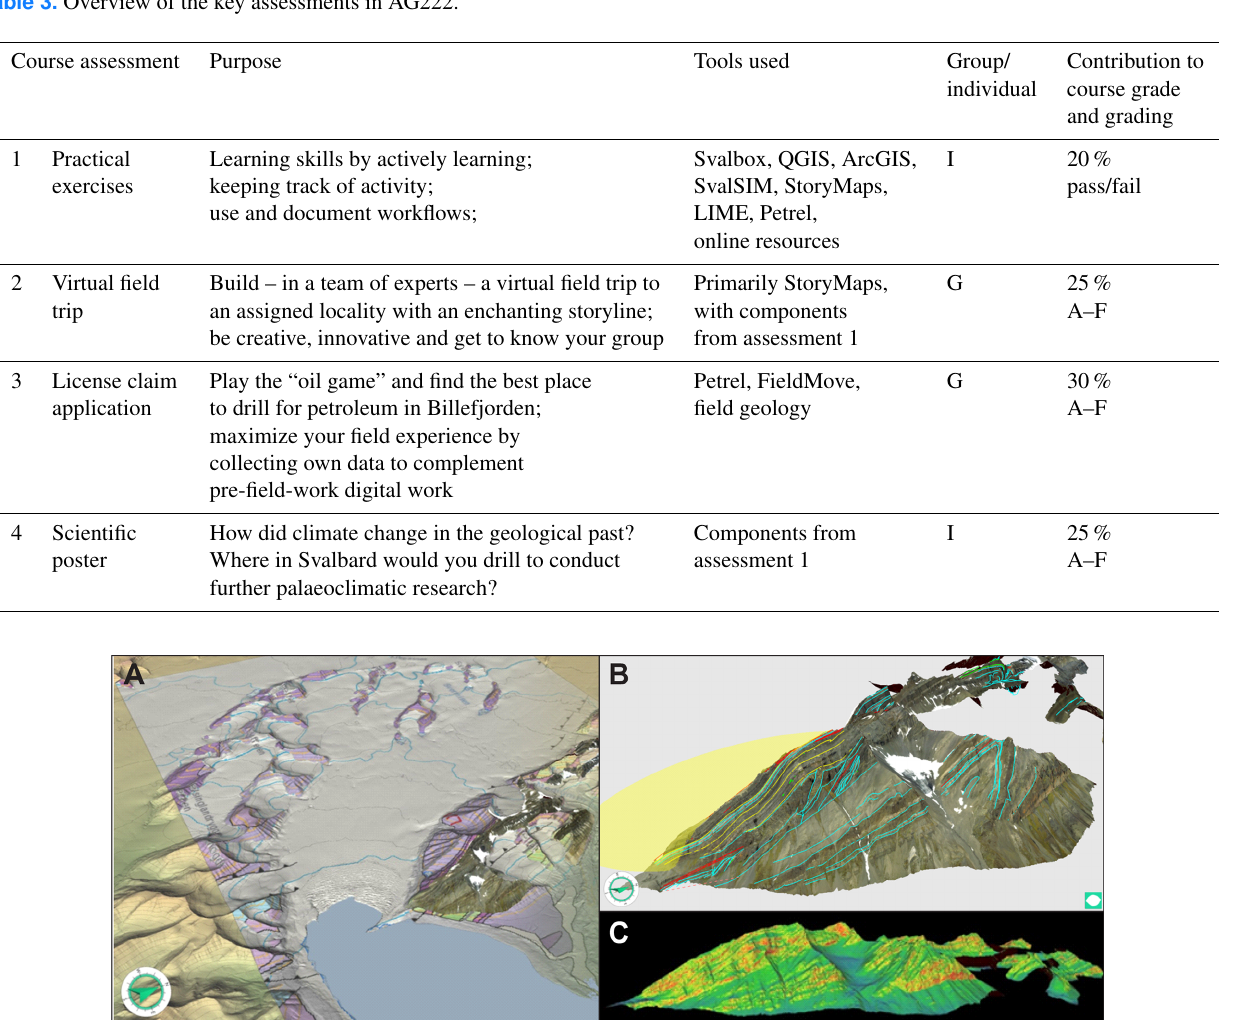
Table 3. Overview of the key assessments in AG222.